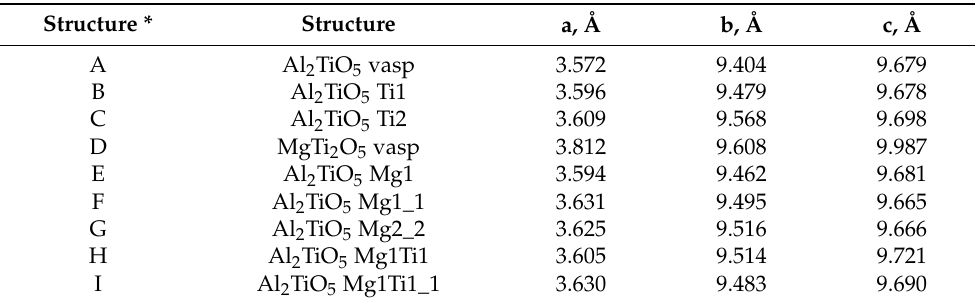
Figure 4. Comparison of changes in lattice parameters of tialite elementary cell and its solid solu- tions in systems stabilized with different amounts of MgTi 2 O 5 and tialite without stabilizers (AT). Table 3. Changes in lattice parameters of Al 2 TiO 5 after exchange of Al for Mg or Ti, calculated with different amounts of Mg or Ti exchange atoms.